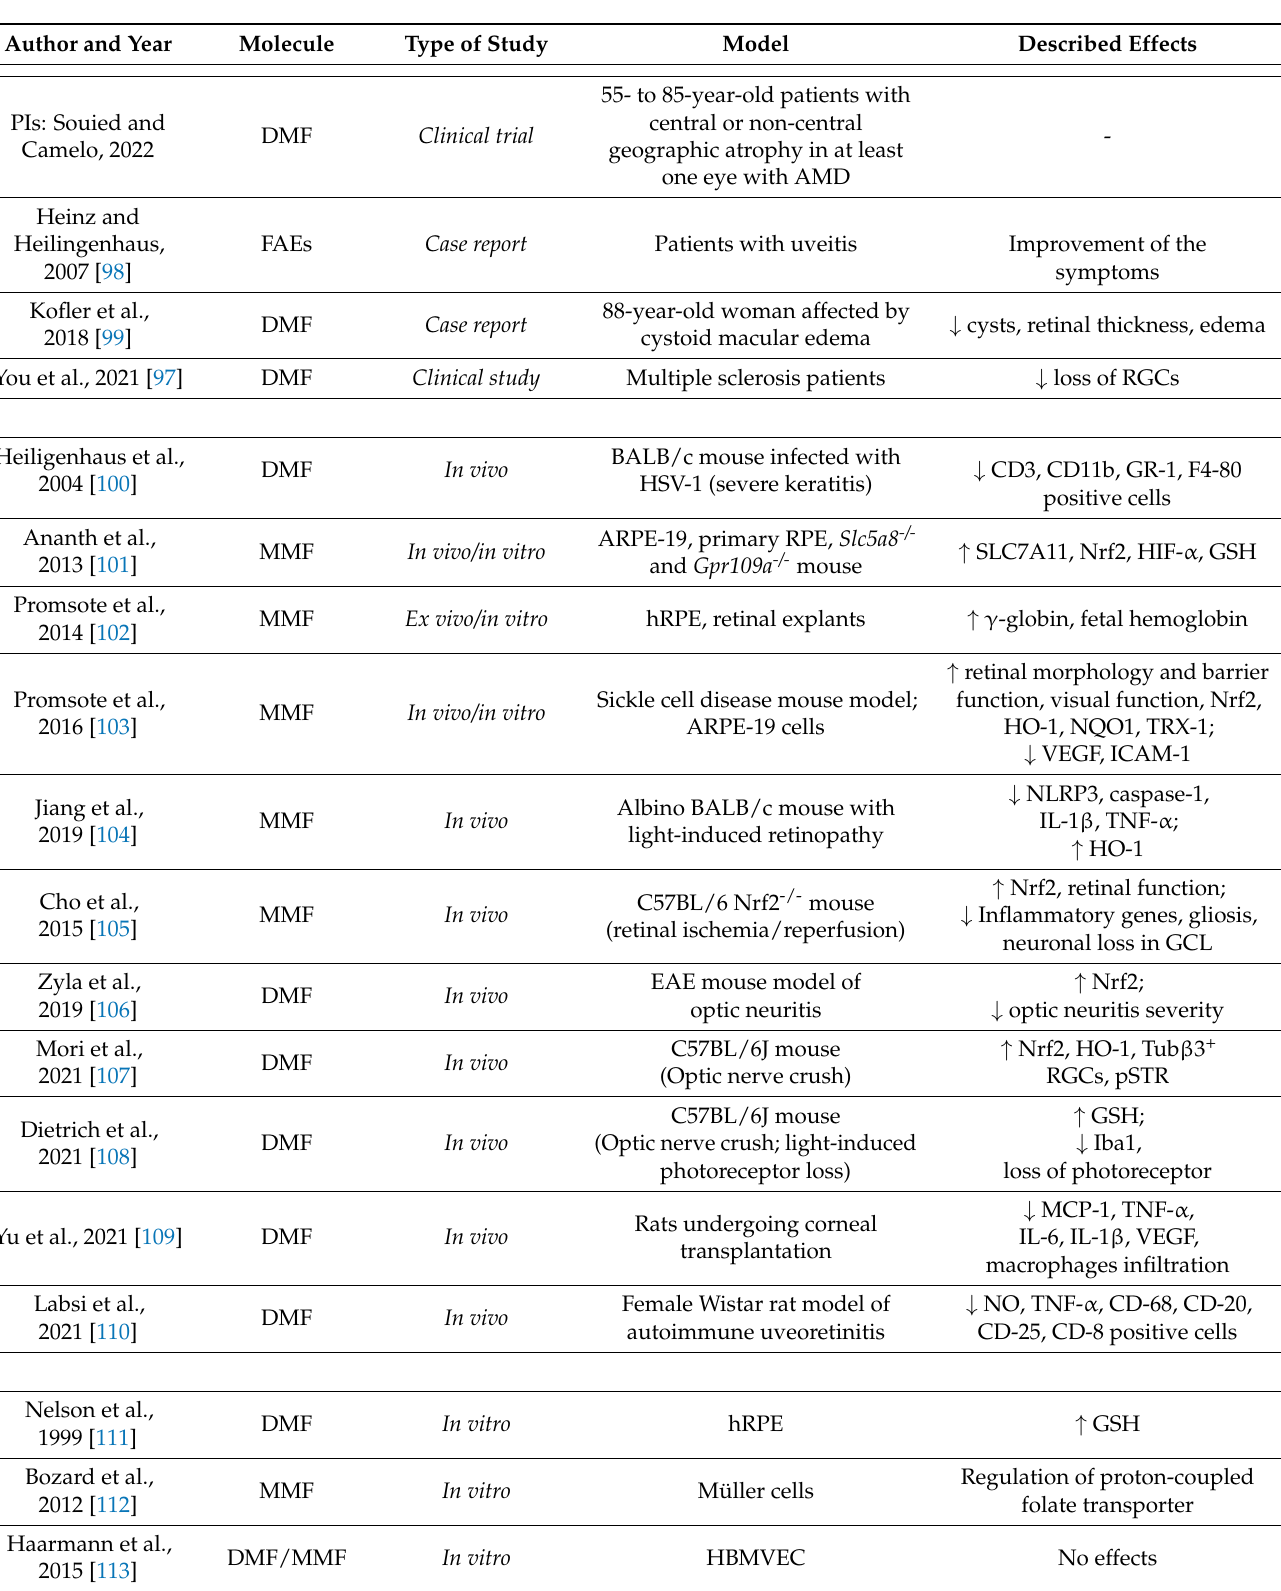
Table 2. Studies and clinical trials about DMF applications in the context of ophthalmological diseases. The symbol ↑ indicates “increase”, whereas ↓ indicates